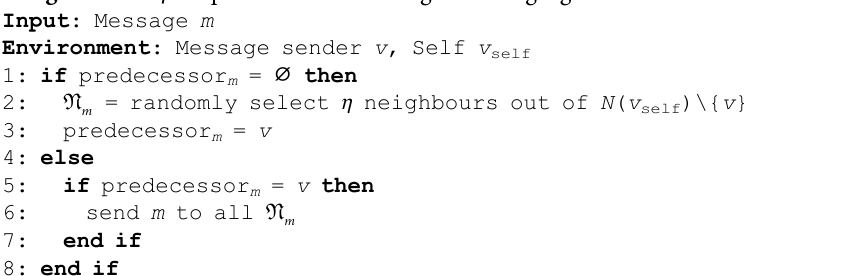
Algorithm 1 η -adaptive diffusion message handling